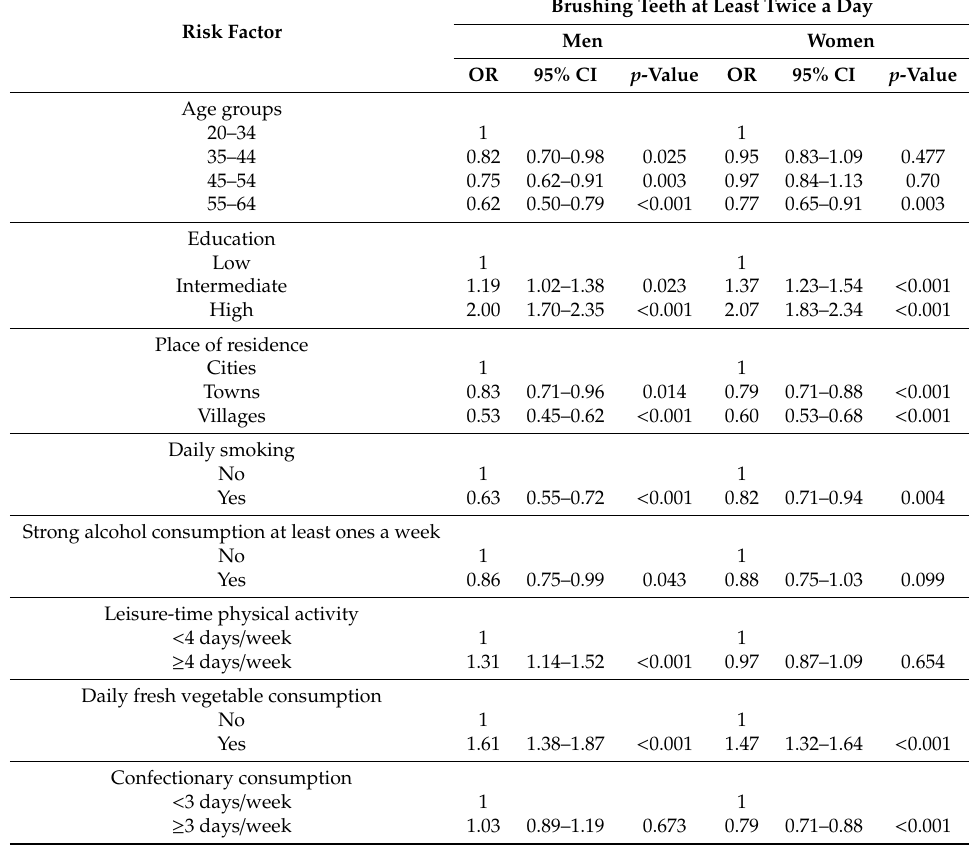
Table 4. Odds ratios * and 95% confidence intervals for brushing teeth at least twice a day. Brushing Teeth at Least Twice a Day Risk Factor Men Women OR 95%